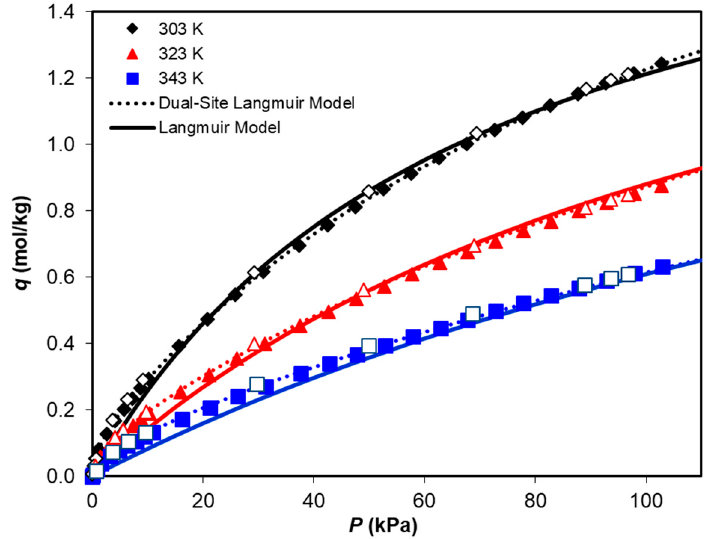
Figure 8. Adsorption equilibrium isotherms of CO 2 on ZSM-5 extrudates at 303, 323, and 343 K. The filled symbols denote adsorption data and open symbols denote desorption data. Solid and dashed lines represent the fittings obtained using the Langmuir and dual-site Langmuir models, respectively. Table 3. Langmuir and dual-site Langmuir fitting parameters for CH 4 , CO 2 , and H 2 O adsorption on ZSM-5 extrudates.